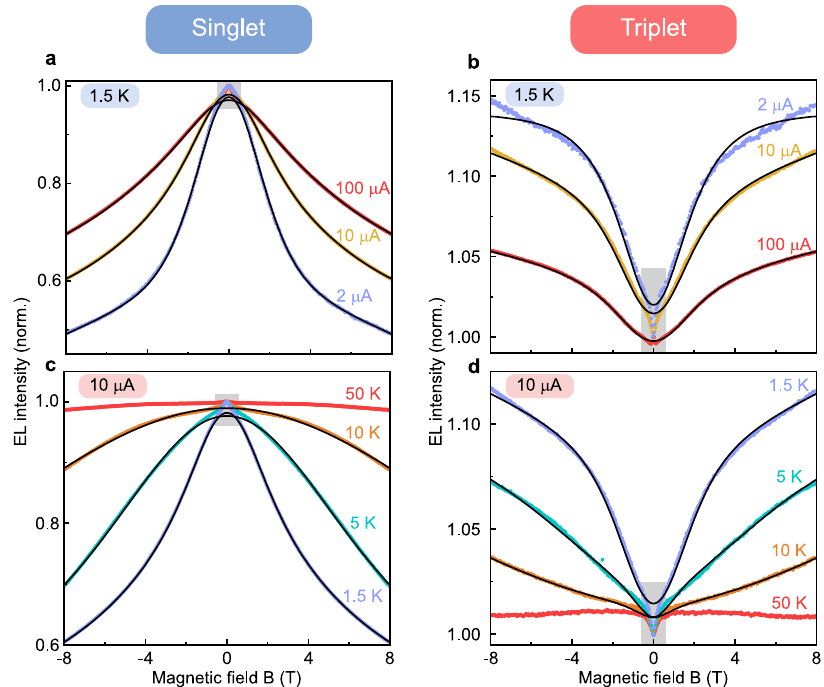
Fig. 4 Current and temperature dependence of the singlet and triplet EL intensity of a dual-emitting OLED. The current dependence ( a , b ) is shown at a temperature of 1.5 K and the temperature dependence ( c , d ) at a current of 10 μ A. The lines show a fi t to the data of the combined functional dependence of TSP and the Δ g effect following Eq. (4). At higher currents and at low temperatures, a narrow feature is observed around zero fi eld (gray areas), which is attributed to the effect of spin mixing due to hyper fi ne interactions. This gray region is excluded in the fi tting procedure. The triplet intensity is quenched at high fi elds for the 50 K curves at 10 μ A, so there is no meaningful fi t